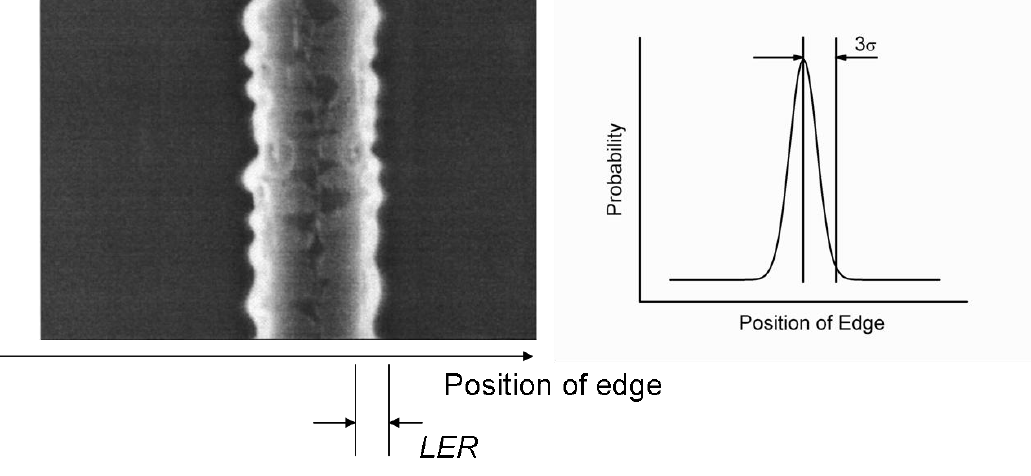
Figure 7. Definition of line edge roughness (LER). A normal distribution (right) of the line